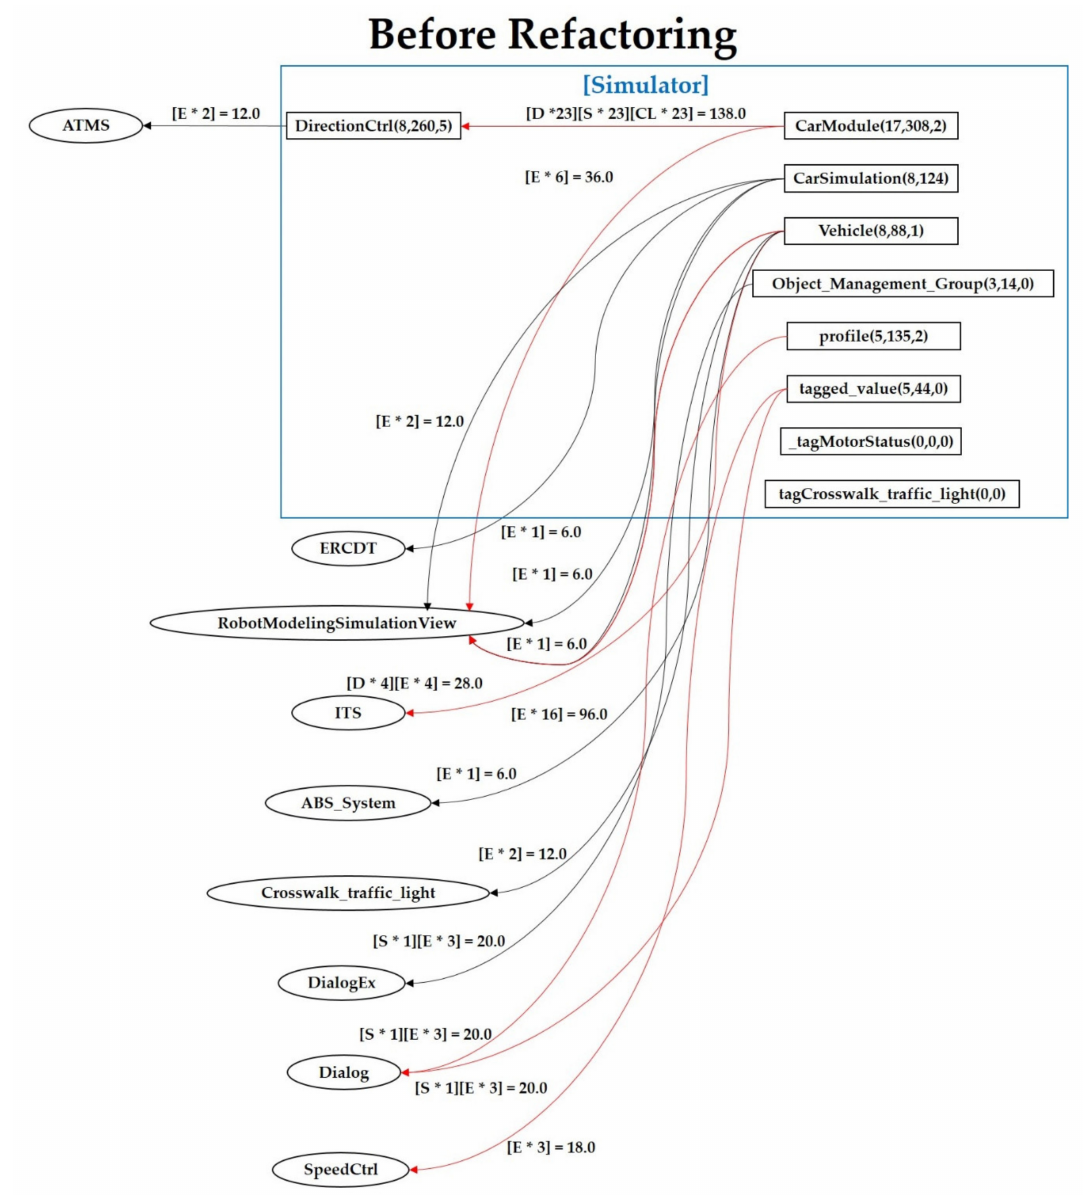
Figure 10. Inner code visualization of smart tra ffi c control simulator before